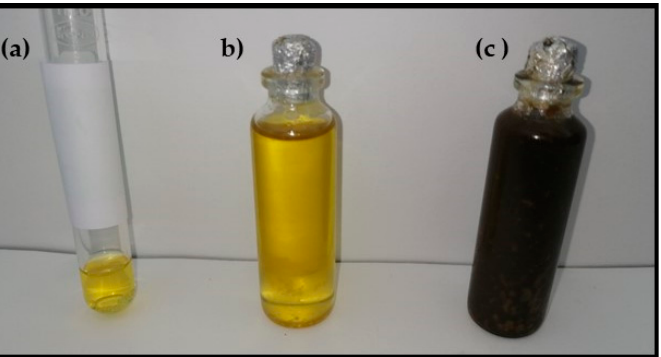
Figure 5. Pistacia atlantica subsp. atlantica oils: ( a ) essential oil obtained by hydrodistillation; ( b ) solvent fixed oil obtained by using a Soxhlet; ( c ) fixed oil obtained by using the traditional method; kindly provided by a friend from the region of El bayadh (Algeria). Personal photo taken by the first author.